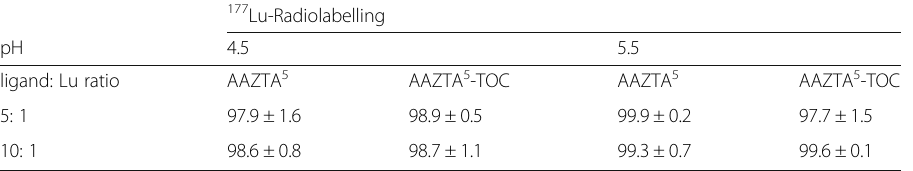
Table 3 Radiolabelling data for [ 177 Lu]Lu-AAZTA 5 and [ 177 Lu]Lu-AAZTA 5 -TOC 177 Lu-Radiolabelling